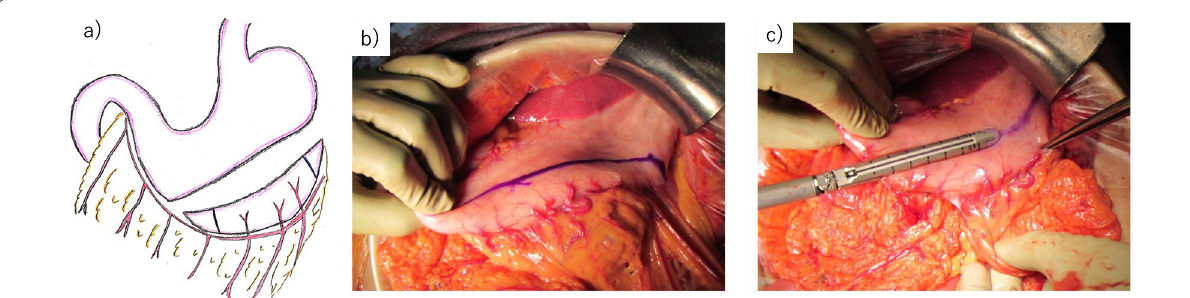
Fig. 4 Trimming for establishment of gastric conduit a The incision line for the gastric conduit was determined. b The gastric conduit was marked to establish a tube approximately 1.5 cm wide. c The stomach was cut away using a linear stapler to keep it straight toward the fornix